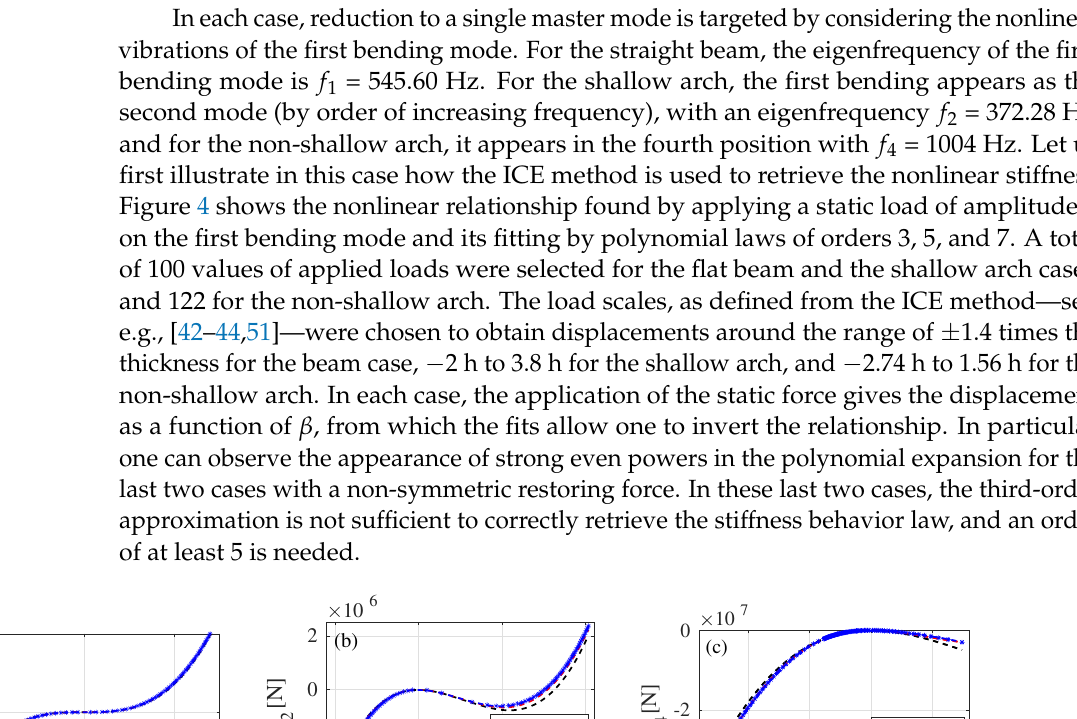
Figure 3. The three beams under investigation with the mesh used and the deformed shape of the bending mode under study—flat beam with 60 elements; arches with increasing curvature and 96 elements.